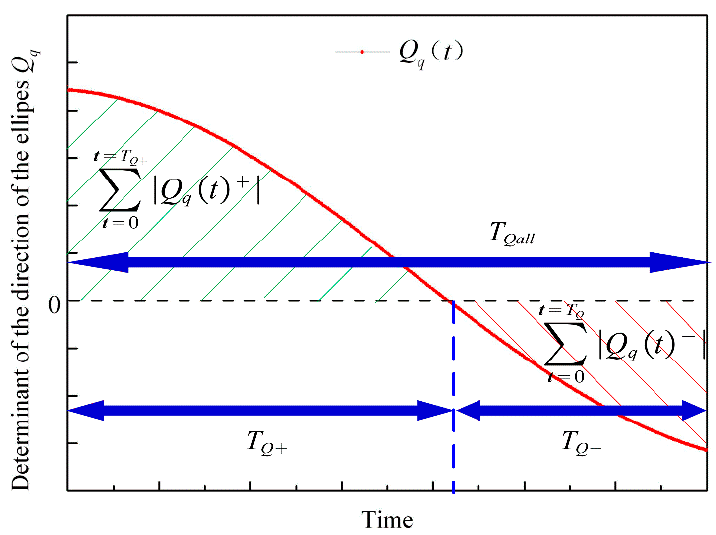
Figure 19. Schematic diagram of determining factors for the direction of the motion.